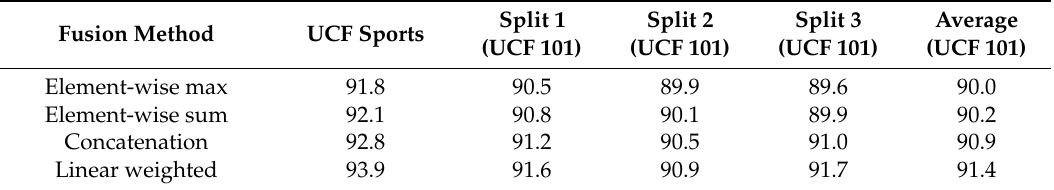
Table 2. Effect of different earlier fusion methods on our model. The accuracy (%) is computed on a UCF Sports dataset, and all three splits and their average on UCF101.